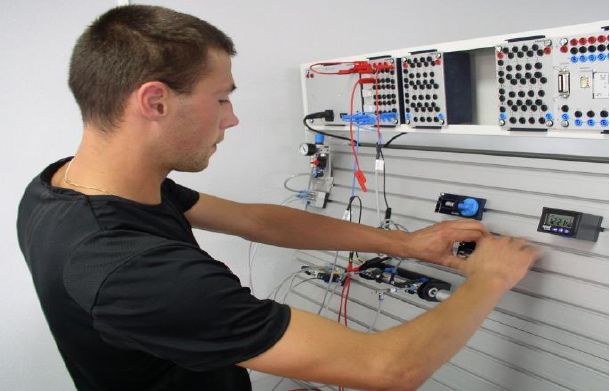
Figure 11. The automated pneumatic drive